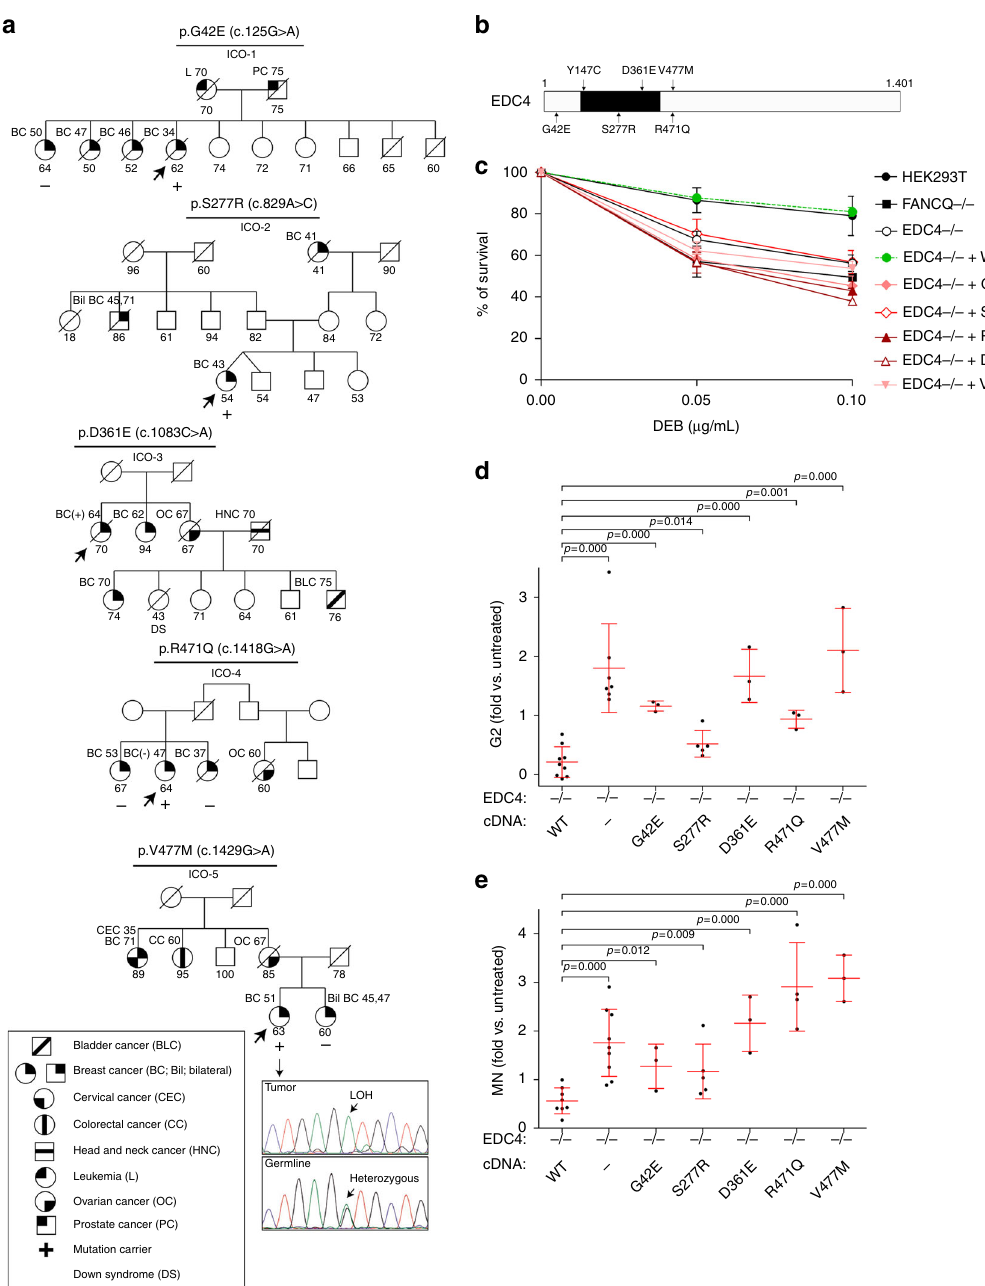
Fig. 5 Rare EDC4 germline variants identi fi ed in breast cancer patients are functionally deleterious. a Pedigrees of the fi ve breast cancer families with EDC4 mutations (based on NP_055144). The probands are indicated by arrows, and slashed symbols denote deceased individuals. The ages at diagnosis and/or death are included when known. Individuals genotyped for mutations are marked either as carriers ( + ) or non-carriers ( − ). Additional clinical annotations are depicted as shown in the inset. b Diagram showing that all the residues mutated in BRCA1/2 -mutation-negative patients cluster inside or close to the WD40 domain of EDC4. c Functional studies of mutations found in patients shown in a . All EDC4 mutants fail to revert the DEB sensitivity phenotype of HEK293T EDC4 − / − cells. Graph shows survival after DEB treatment of fi ve EDC4 mutants generated in HEK293T cells. Data shown represent results from at least two combined independent experiments. Error bars indicate mean ± s.d. Means were statistically compared using the two-tailed Student ’ s t test: EDC4 − / − ( p = 0.000; p = 0.000), EDC4 corrected ( p = 0.760; p = 0.748), G42E ( p = 0.002; p = 0.005), S277R ( p = 0.024; p = 0.011), D361E ( p = 0.001; p = 0.001), R471Q ( p = 0.010; p = 0.017), and V477M ( p = 0.000; p = 0.000). d HEK293T EDC4 − / − cells expressing the mutants show increased G2/M block induced by DEB treatment. e HEK293T EDC4 − / − cells expressing the mutants show DEB-induced chromosome fragility as shown with the fl ow cytometric MN assay. Data shown in d , e represent results from at least three combined independent experiments. Error bars indicate mean ± s.d. Means were statistically compared using one-way analysis of variance (ANOVA) followed by a Dunnett ’ s multiple comparison